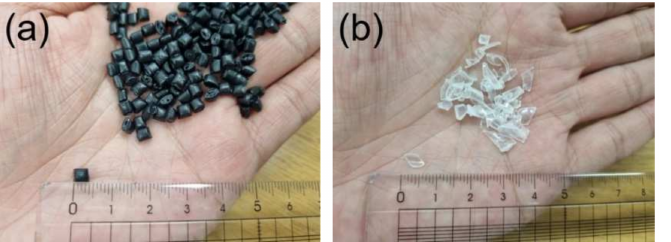
Figure 7. Image of the plastic aggregates showing their shape and size (numbers on the ruler indicate cm): ( a ) pellet; ( b )